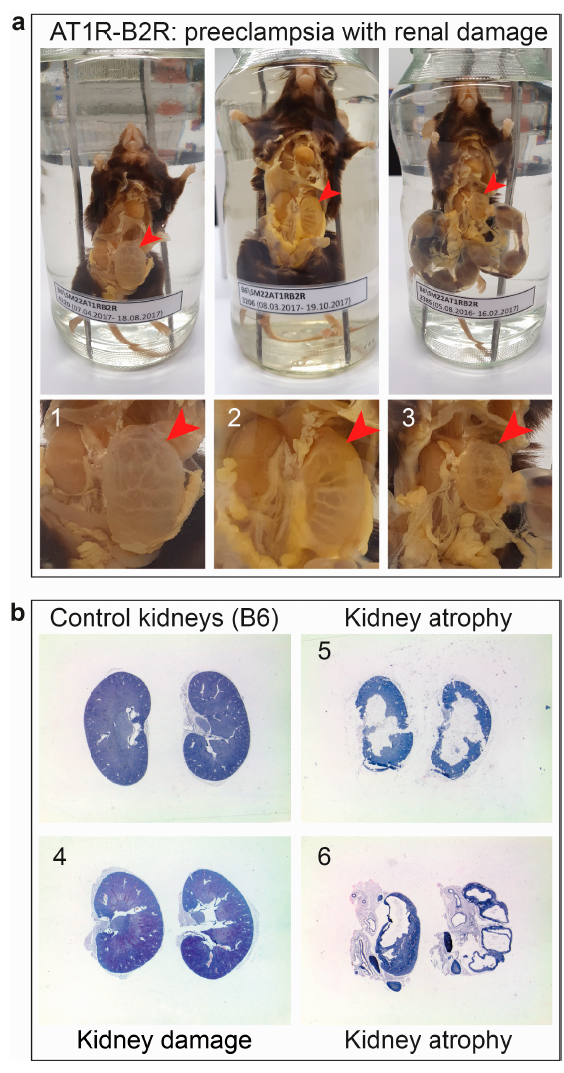
Figure 6. Kidney damage after multiple preeclamptic pregnancies in AT1R-B2R-transgenic mice. ( a ) In situ examination shows preeclampsia symptoms with uterine hemorrhage and abortion (up- per panels), and kidney damage (lower panels) of female AT1R-B2R-transgenic mice (no. 1–3; age: 4–7 months); ( b ) Kidney damage and renal atrophy was detected by histological analysis of hematoxylin-eosin-stained kidney specimens of three female AT1R-B2R-transgenic mice after multi- ple preeclamptic pregnancies (no. 4–6; age 4–7 months). The left upper panel shows control kidney specimens of a non-transgenic, age-matched, female B6 mouse with uncomplicated